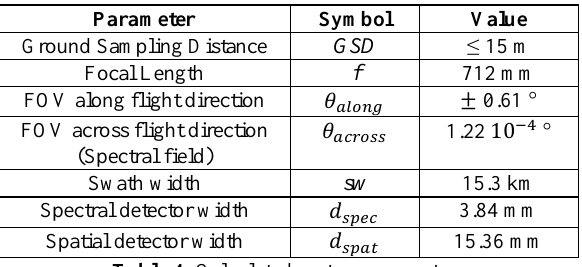
Table 4. Calculated system